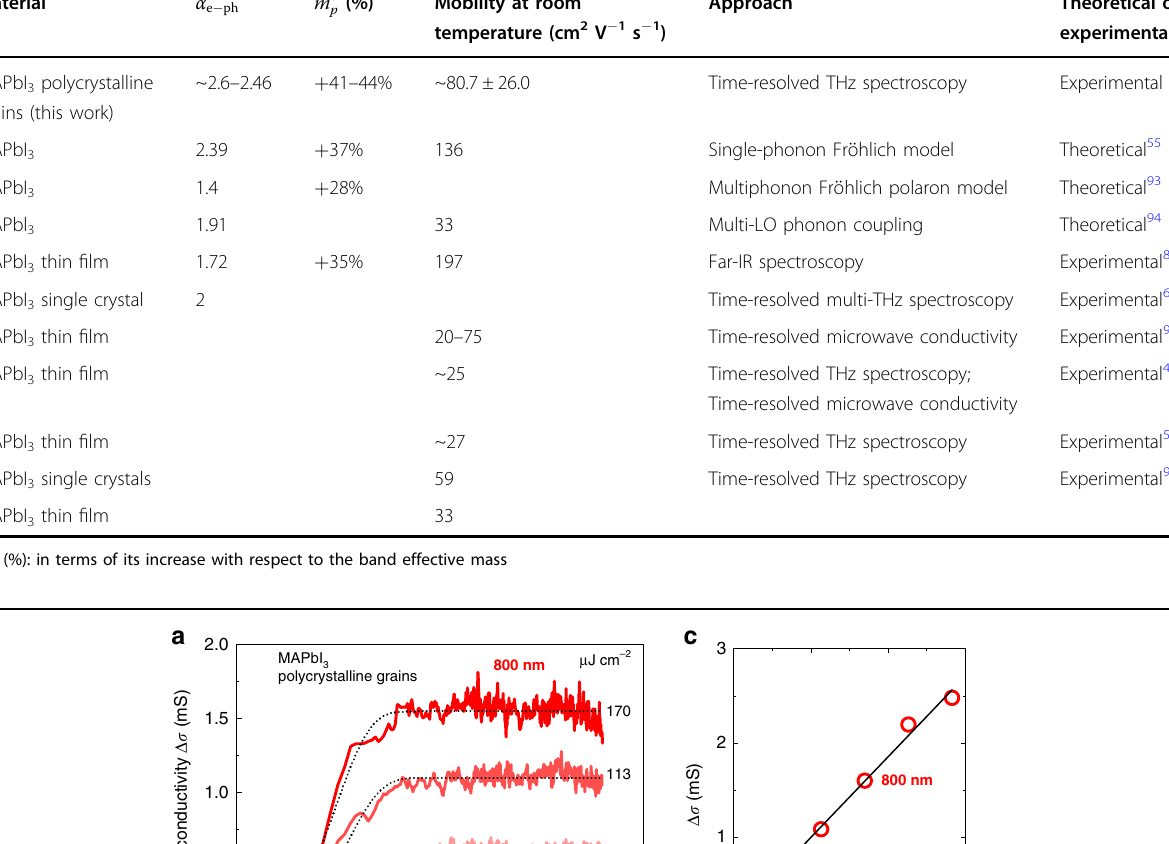
(relative to the band effective p